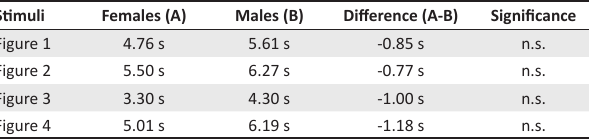
TABLE 9: Peripheral vascular (gangrene) warning: Analysis of both text and pictures. Stimuli Variable Smokers Non-smokers Figure 1 Contact time Figure 2 Contact time GSR, Galvanic skin response.